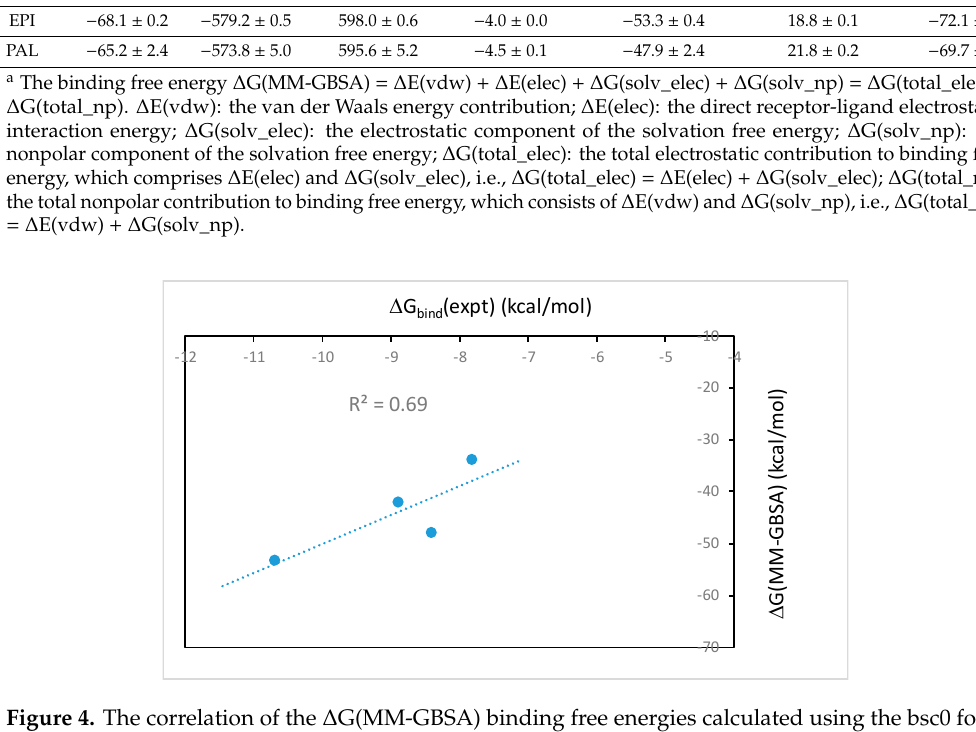
Figure 4. The correlation of the ∆ G(MM-GBSA) binding free energies calculated using the bsc0 force field vs. experimental binding free energies of the investigated protoberberines with wtTel26 in K + solution.